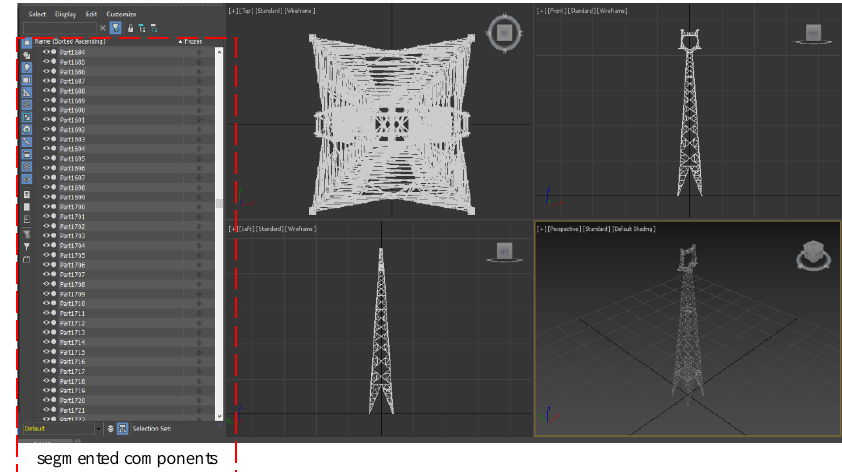
Figure 2. Analysis of the 3D information model of a transmission tower.